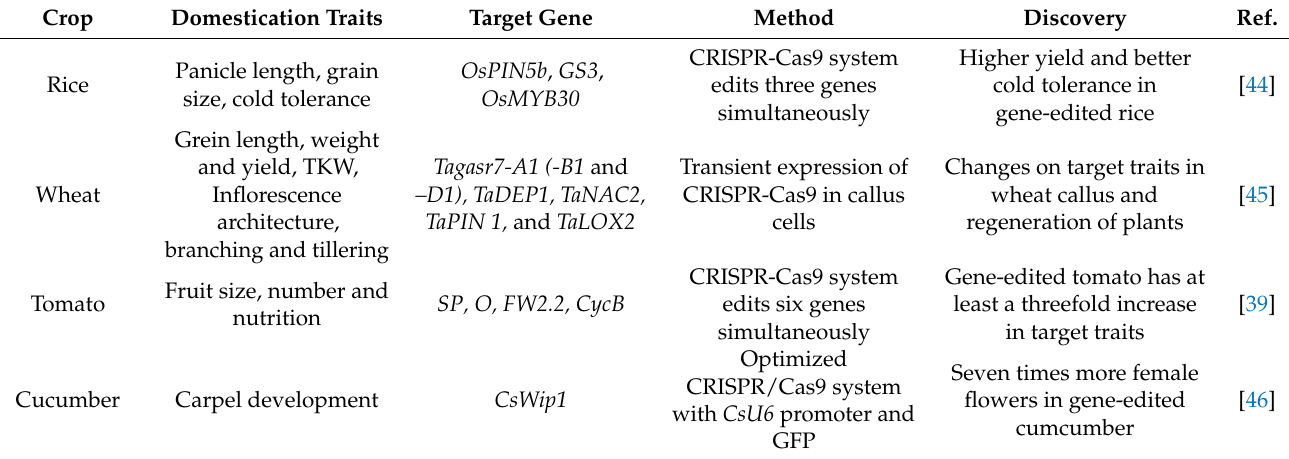
Table 4. The application of CRISPR-Cas to crop domestication.